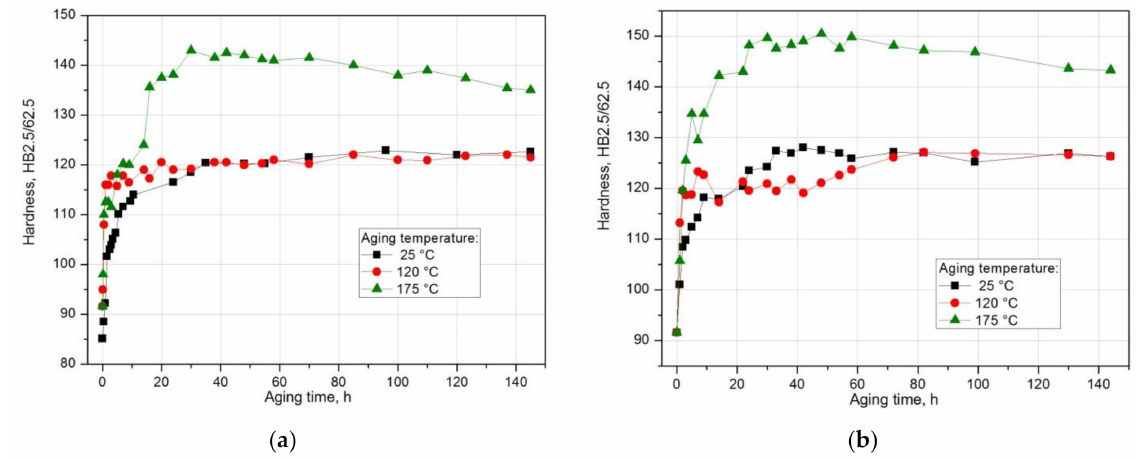
Figure 18. Effect of aging temperature and time on the change in the hardness of an alloy solution heat treated from ( a ) 490 ◦ C and ( b ) 510 ◦ C and aged naturally and